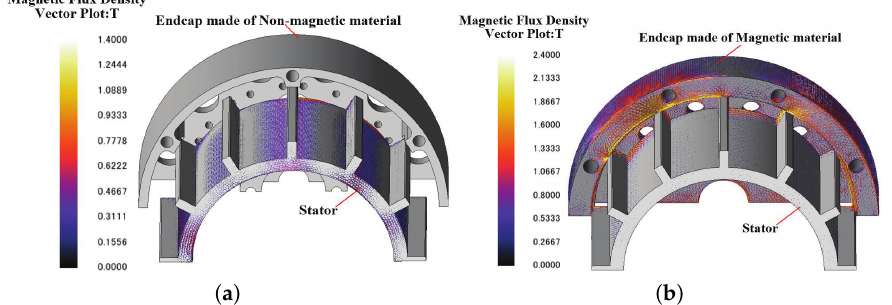
Figure 4. Magnetic flux distributions when installing end caps made of different materials. ( a ) Non- magnetic material. ( b ) Magnetic